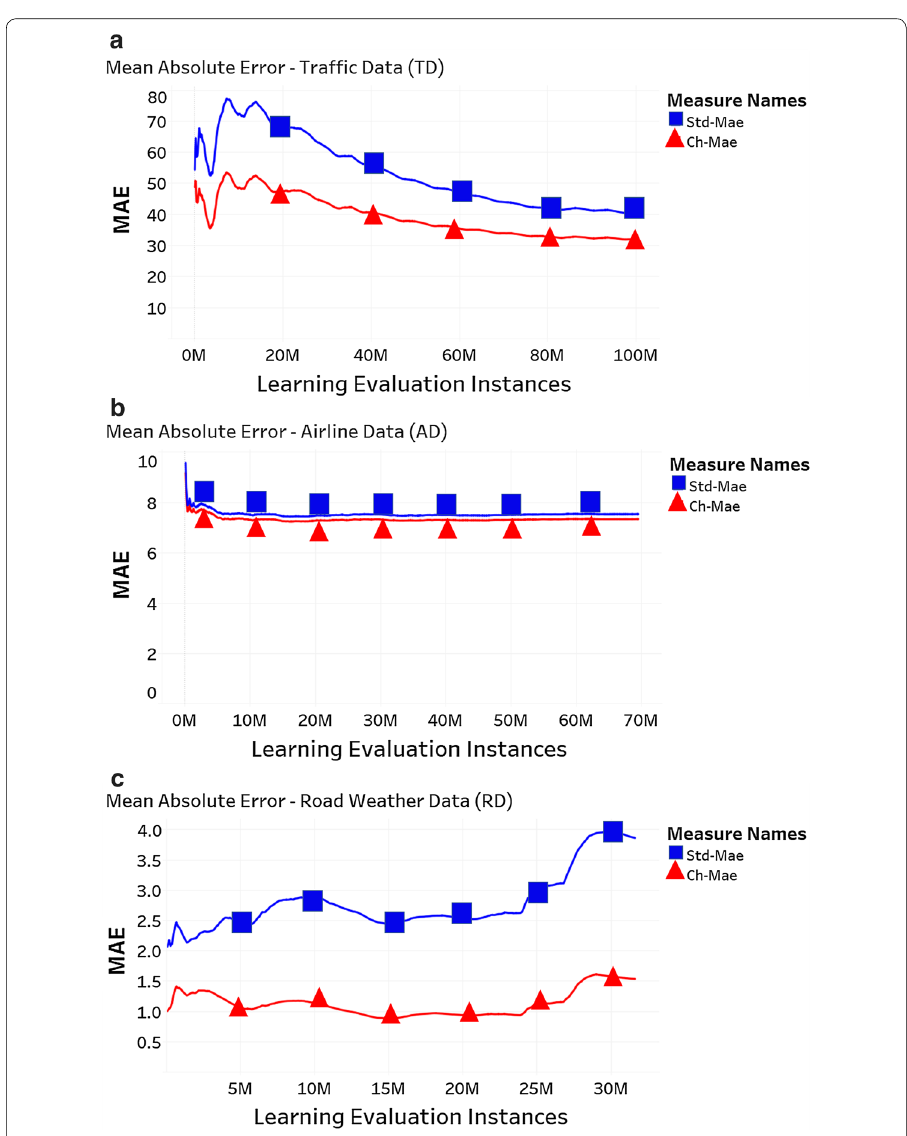
Fig. 2 MAE value measurement of Hoeffding bound (std-mae) and Chernoff bound